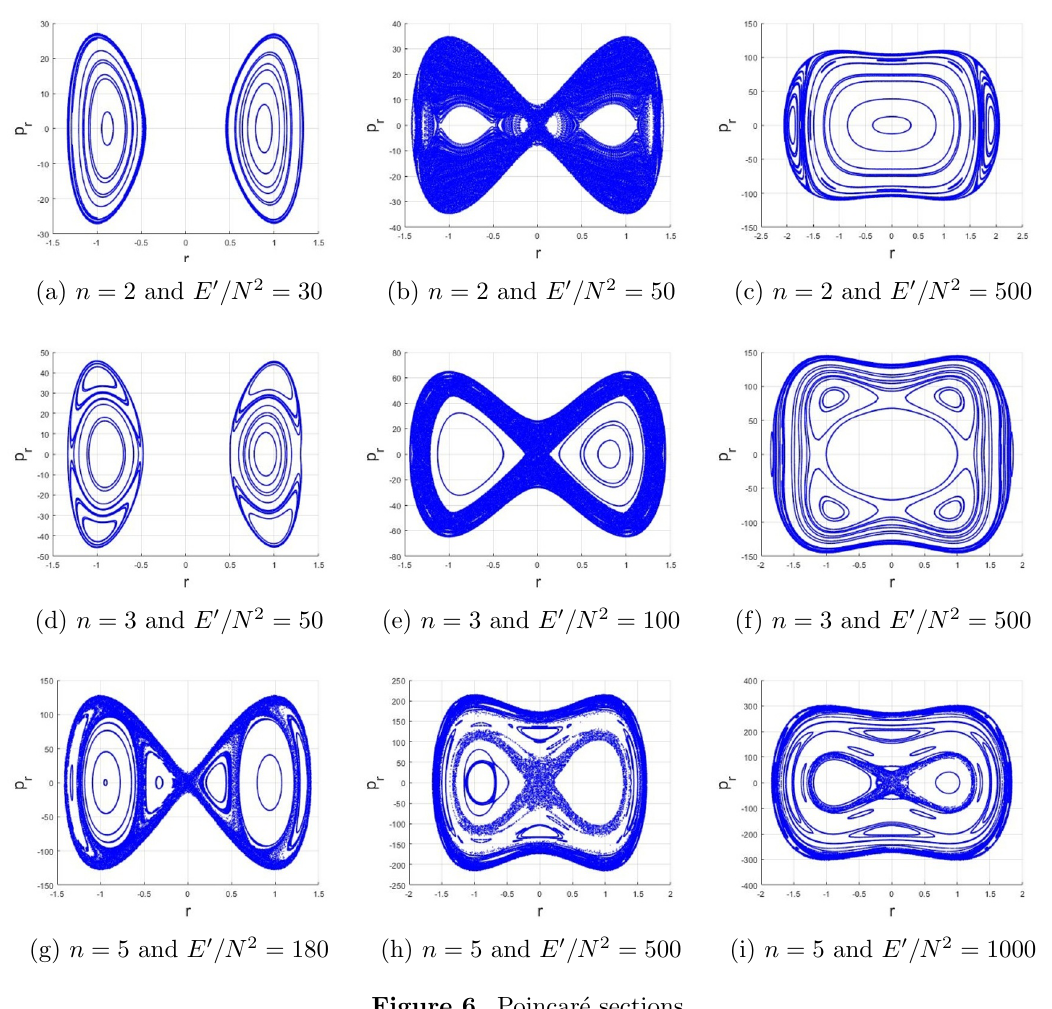
Figure 6. Poincar(cid:19)e